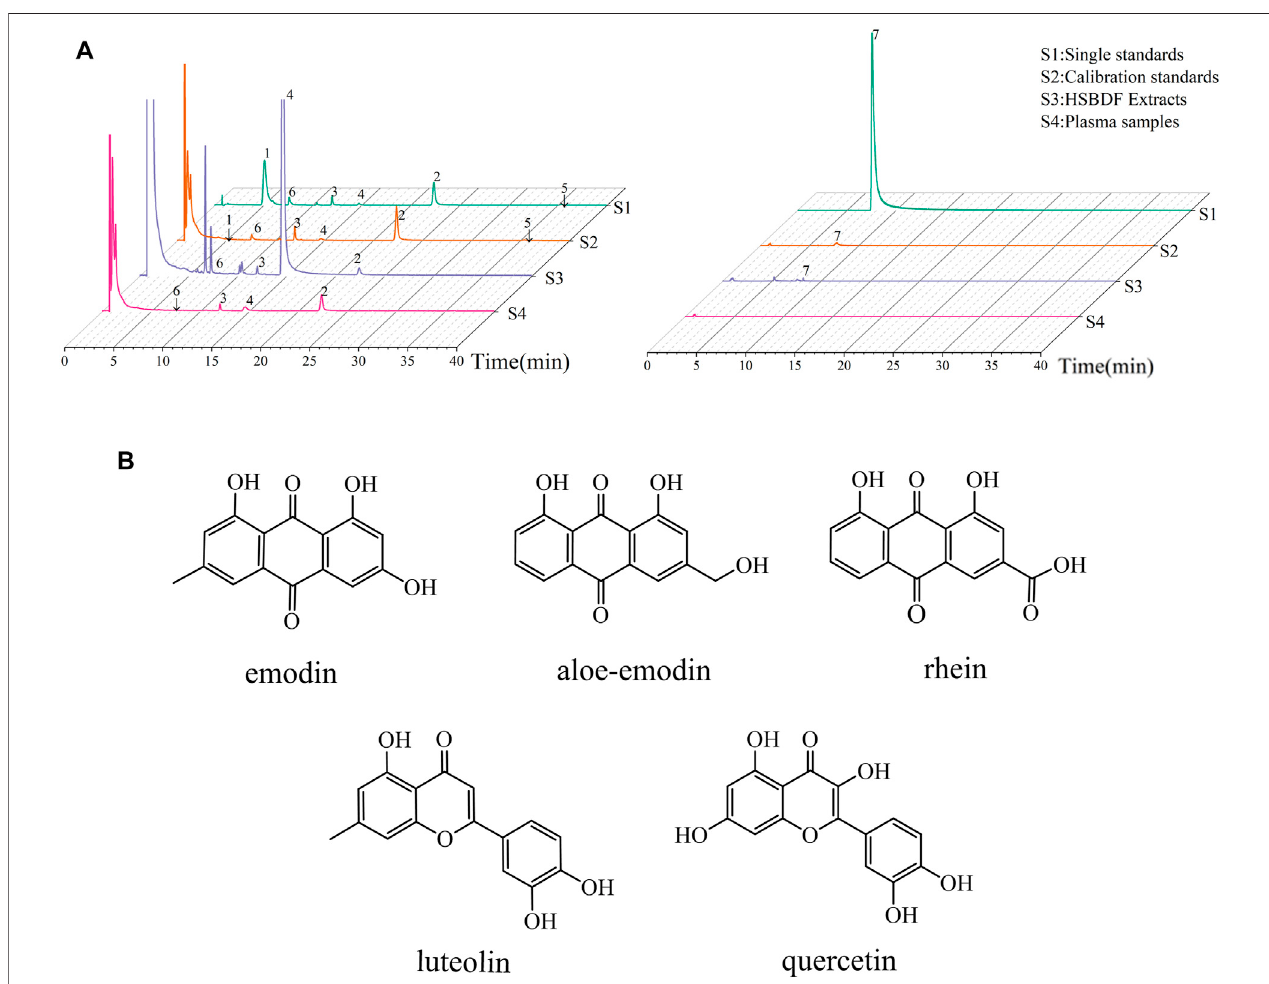
FIGURE 1 | Key compounds analysis by LC/MS. (A) MRM chromatograms ofkey compounds (1 – 7 represent piceatannol, emodin, aloe-emodin, rhein, physcion, luteolin, and quercetin, respectively); (B) structure of key compounds in plasma.